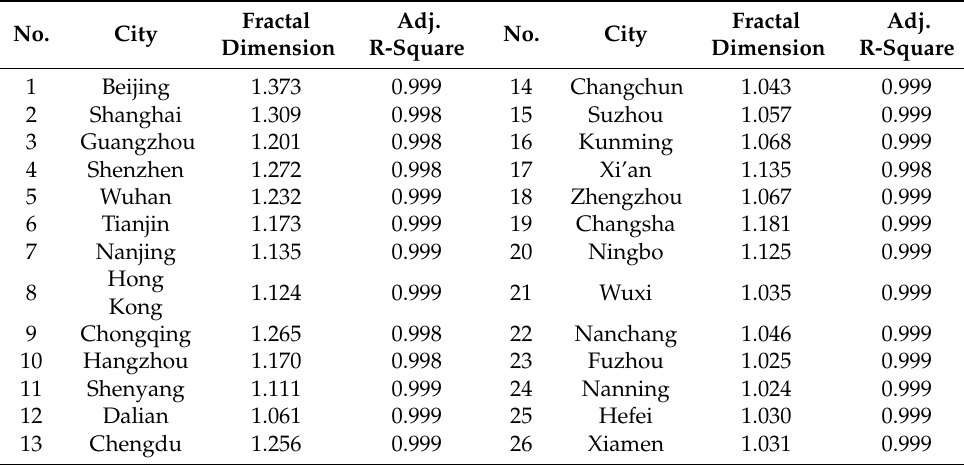
Table 2. Fractal dimensions of 26 metro networks in